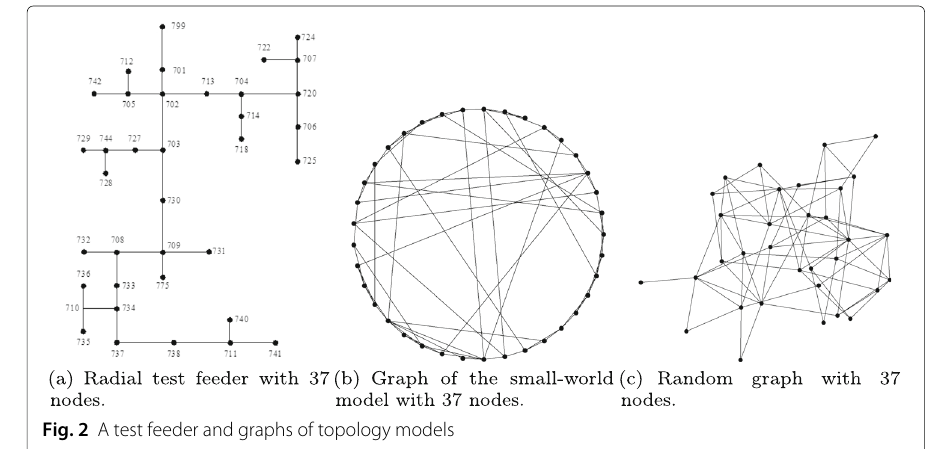
Fig. 2 A test feeder and graphs of topology